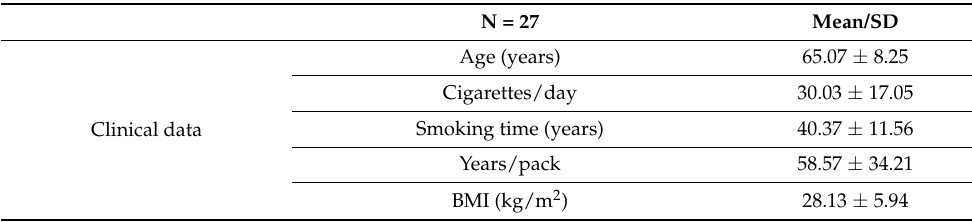
Table 1. Distribution of mean values for demographic and functional variables in patients with severe and very severe